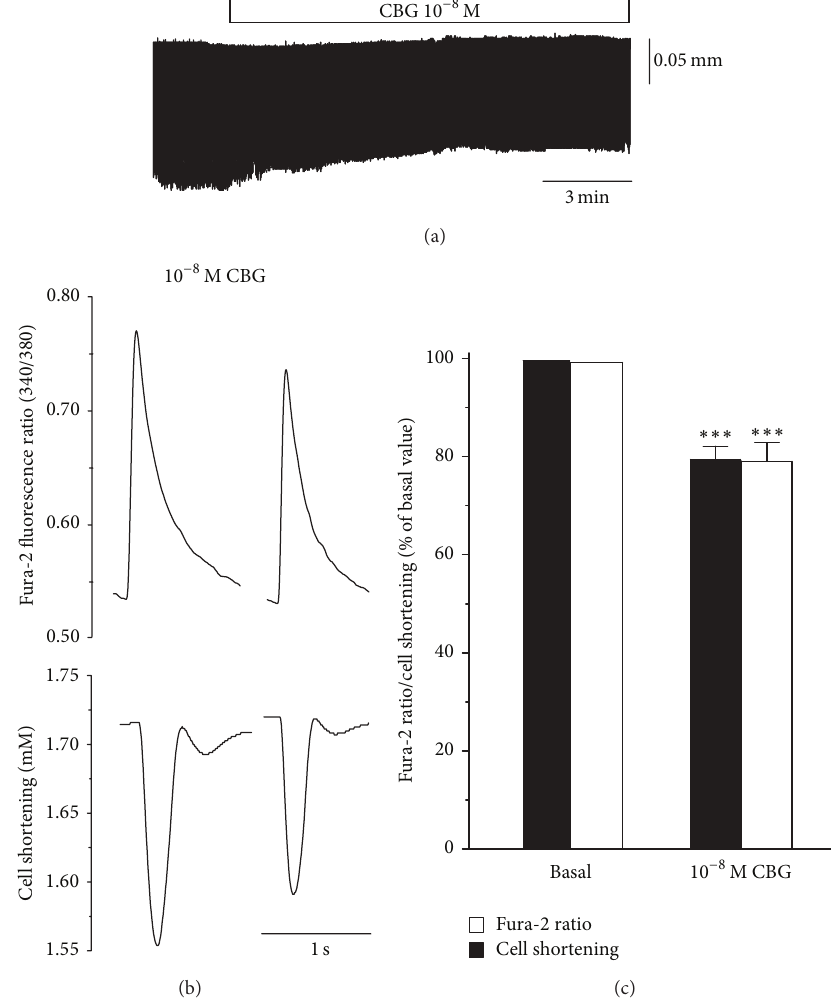
Figure 7: Effects of CBG on Ca 2+ transients and cell shortening in isolated rat ventricular myocytes. (a) Actual tracings of effects of 10 −8 M CBGinamyocyte.(b)Individualsignalsoffura-2ratio(uppertracings)andcellshortening(lowertracings).Individualtracingswereobtained by averaging five successive signals. (c) Summarized data on effects of 10 −8 M CBG on fura-2 ratio and cell shortening. Data are presented as means ± S.E.M. ( 𝑛 = 7 –12 cells). ∗∗∗ 𝑃 < 0.001 , compared with